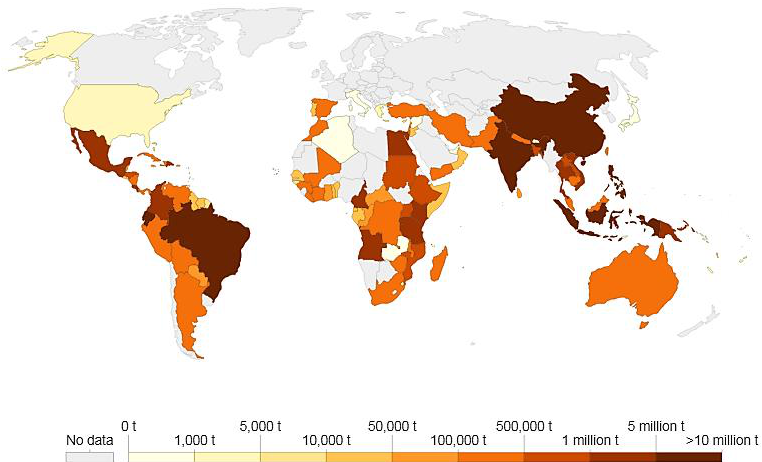
Figure 3. Global growth rates projected for banana production (2019–2024) (adapted from [21]).